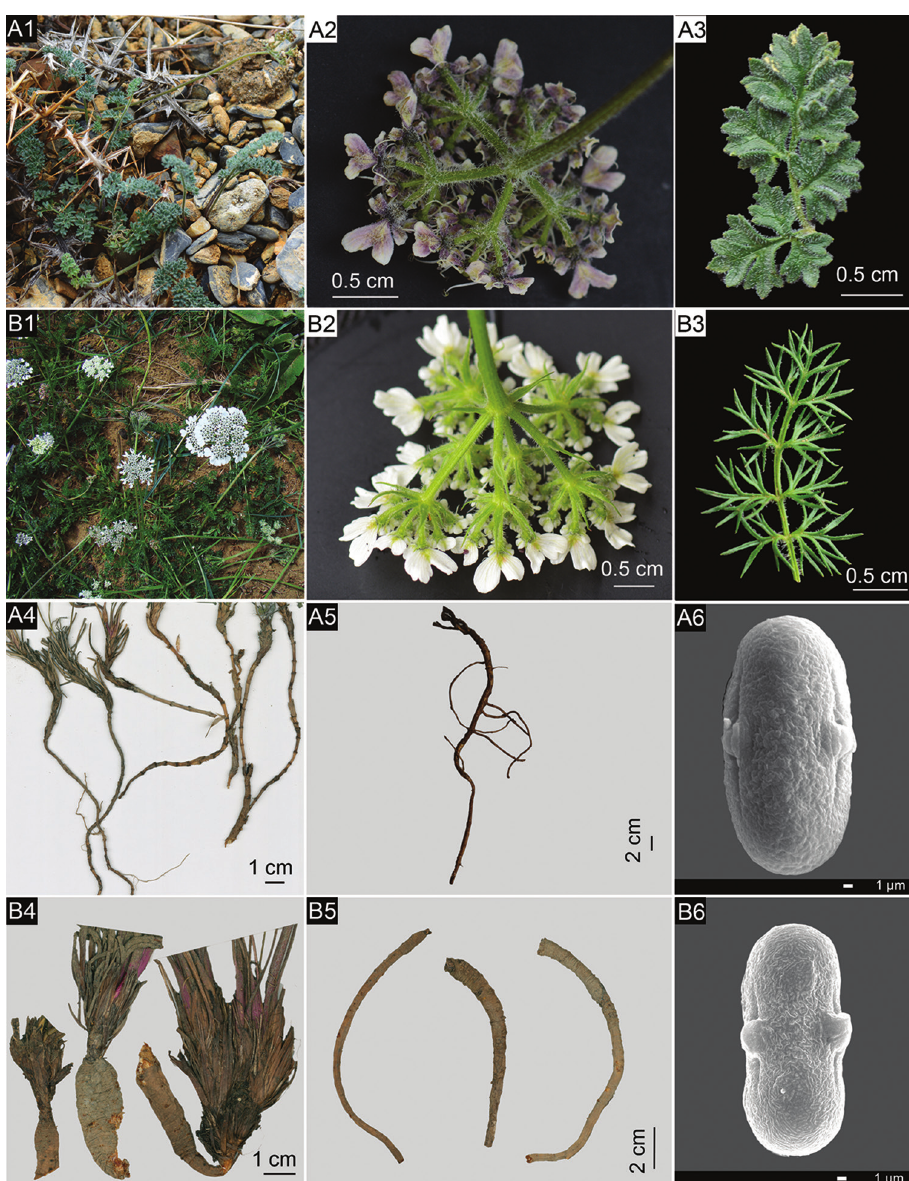
Figure 2. Diagnostic morphological characters of Semenovia gyirongensis ( A1–A6 ) in comparison to the similar species Semenovia malcolmii ( B1–B6 ) A1–B1 Habitat A2 Oblong minute bracts, apex obtuse- rounded or cuneate B2 linear to narrowly ovate bracts, apex acute A3 narrowly ovate to ovate ultimate leaf lobes B3 linear to narrowly long-ovate ultimate leaf lobes A4 Long-branched underground caudex with distinct nodes B4 Short-branched overground or emergent caudex A5 Cylindric and much-branched root B5 Fusiform and unbranched root A6 Ellipsoidal pollen grains B6 Equatorially constricted pollen